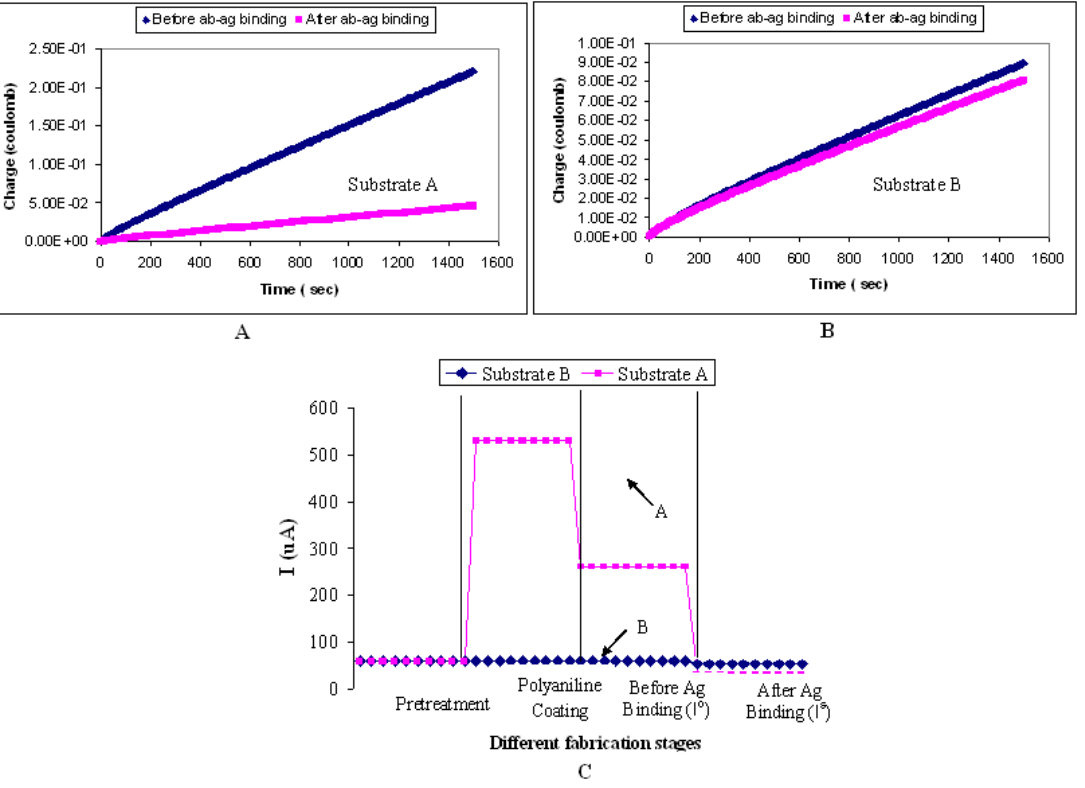
Figure 15. Current-versus-time response of A) substrate A (ITO biosensor spin-coated with self-doped Pani and B) substrate B (ITO biosensor without Pani coating). Amperometric responses of both substrates at every fabrication stage